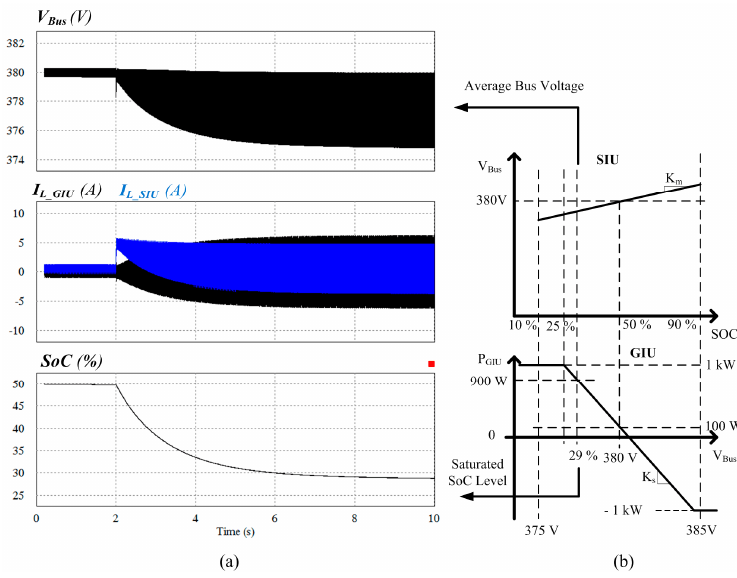
Figure 11. ( a ) Simulation waveforms at step ‐ load changing condition with the battery state ‐ of ‐ charge ( SoC ) varying, and ( b ) master and slave curve design of the system.